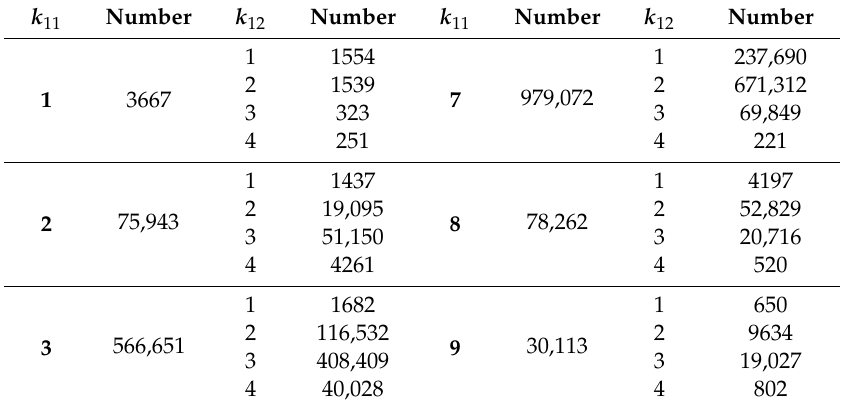
Table 5. Number of pixels per bin for k 1 = 12 * 4, k 11 refers to the division of the first-dimension data into k 11 bins, k 112 refers to the division of the second-dimension data into k 12 bins. Number is the number of pixels (there are 11,718,750 pixels in a study area) falling into each